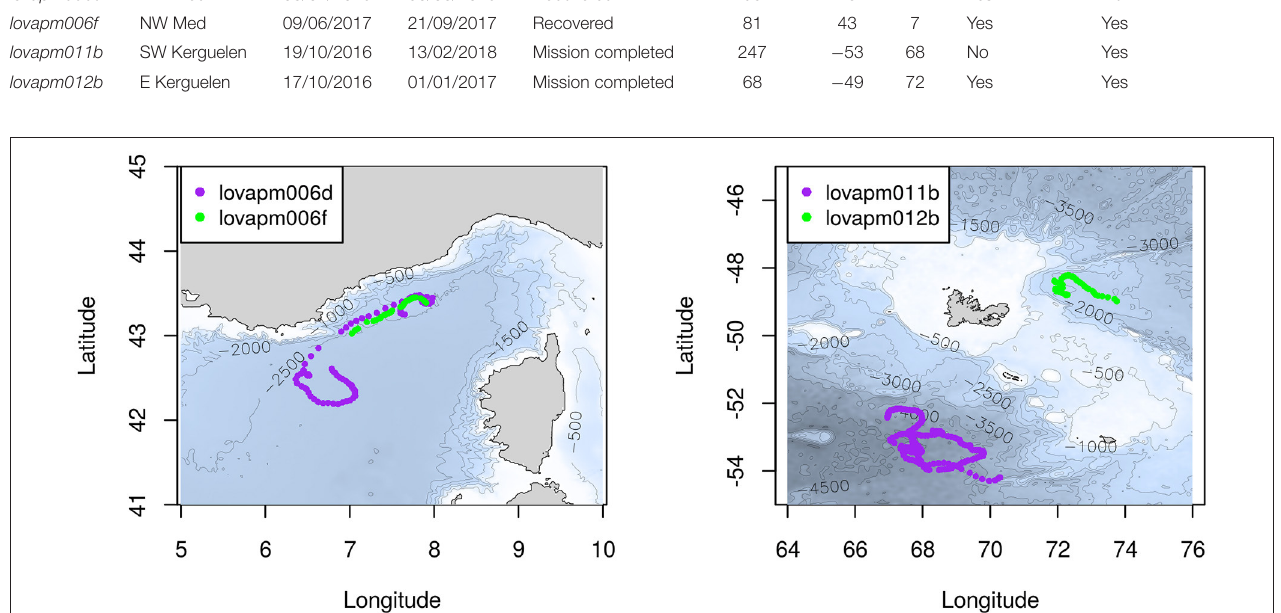
FIGURE 4 | Maps and float trajectories of the deployments in the NW Mediterranean Sea (left) and Southern Ocean (right) .